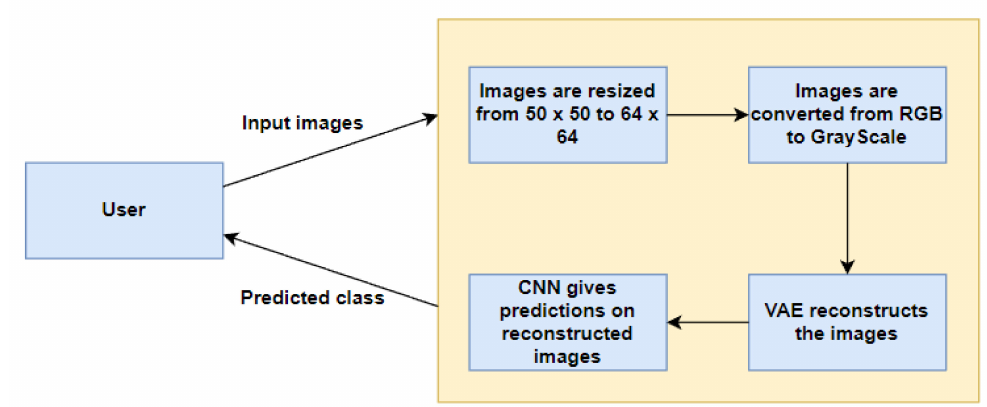
Figure 2. Data Flow Diagram.